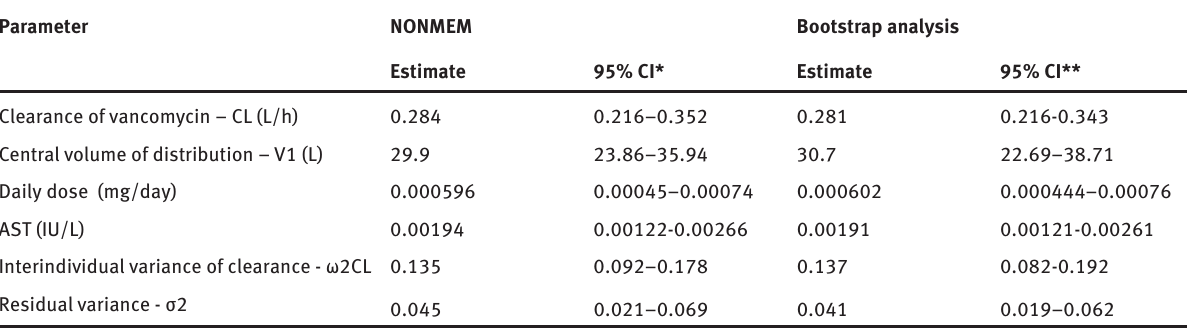
Table 3: The final model parameter estimates in population with impaired renal function